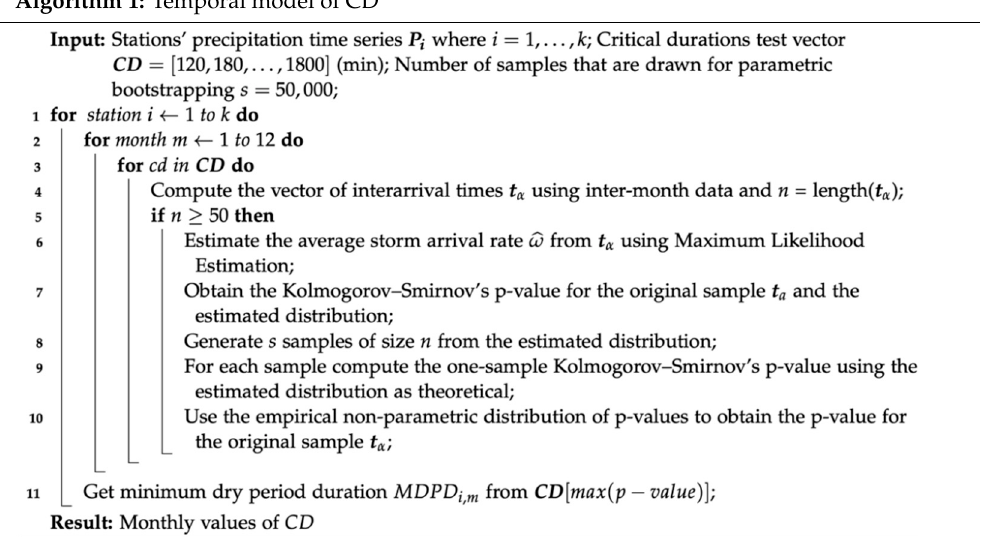
Algorithm 1: Temporal model of